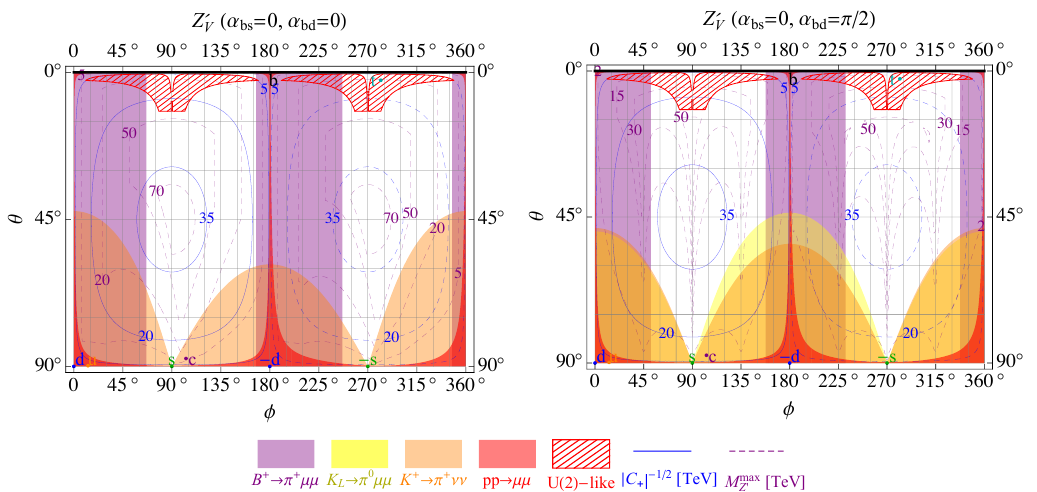
Figure 4 . Limits in the plane ( (cid:30); (cid:18) ) for the vector singlet Z 0 with vector-like couplings to muons and two choices of the phases (cid:11) bs and (cid:11) bd . The dashed purple contour lines are upper limits on the Z 0 mass [TeV] from (cid:1) F = 2 processes using eq.